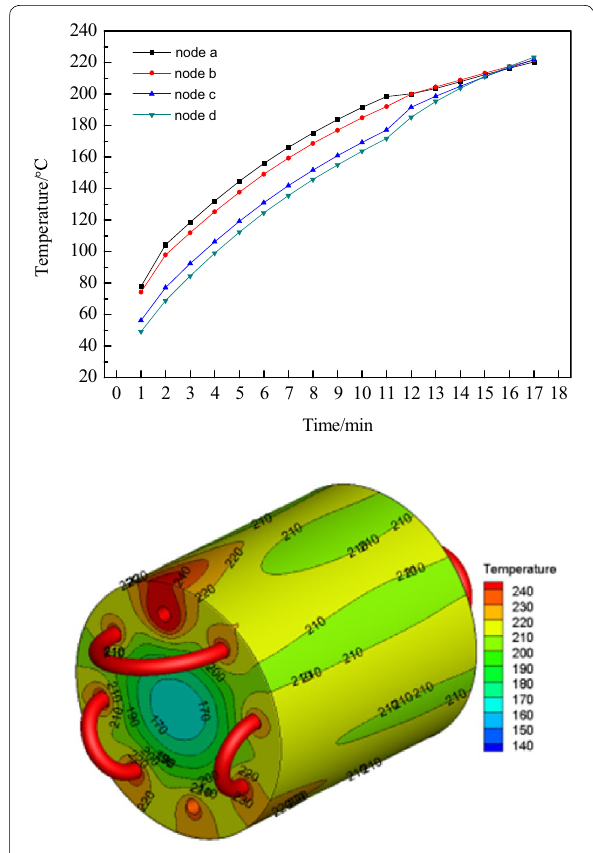
Figure 14 Temperature value of the points a, b, c, and d under different forward flow times: t